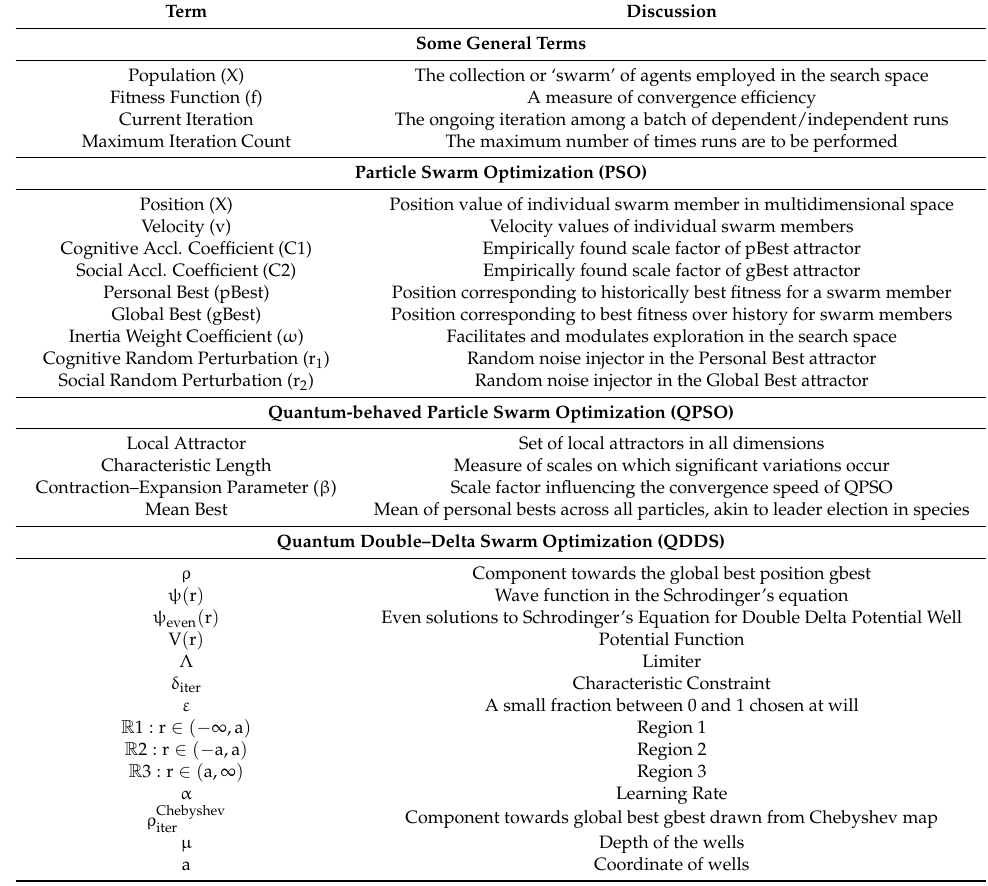
Table 1. General terms used in context of the algorithms and